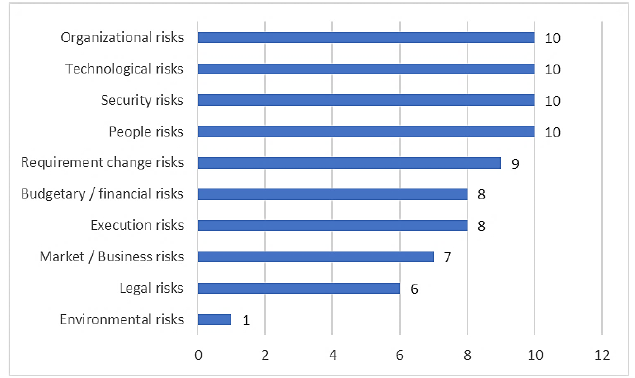
Fig. 7. Frequency of risk categories in the surveyed companies .